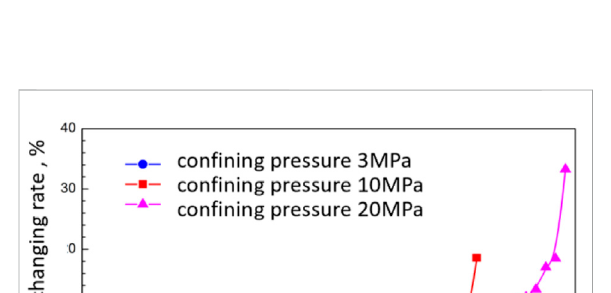
FIGURE 12 Fracture generation curves in slit